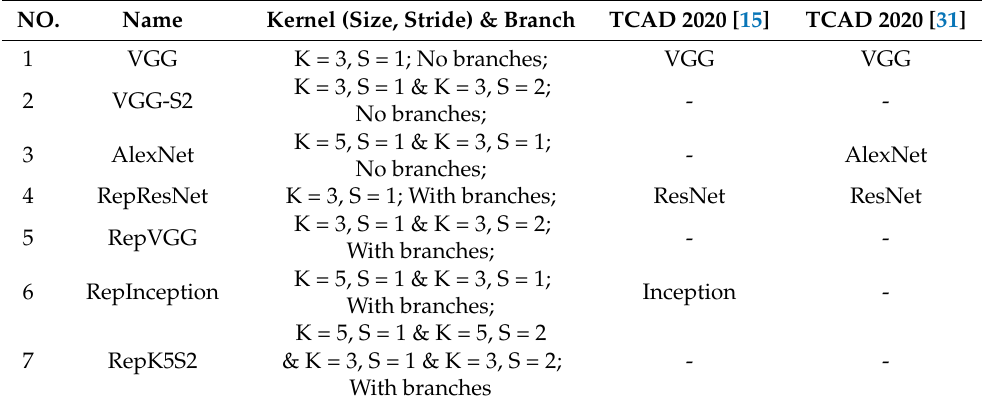
Table 2. Seven CNNs are implemented.